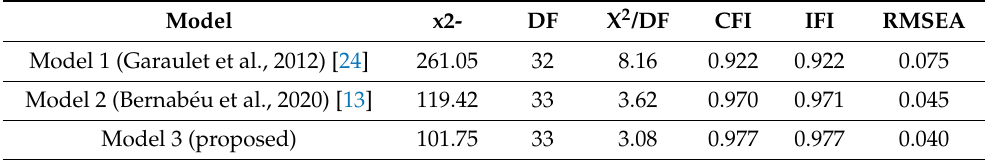
Table 5. Description of the different EEQ models and confirmatory factor analysis of three different models.